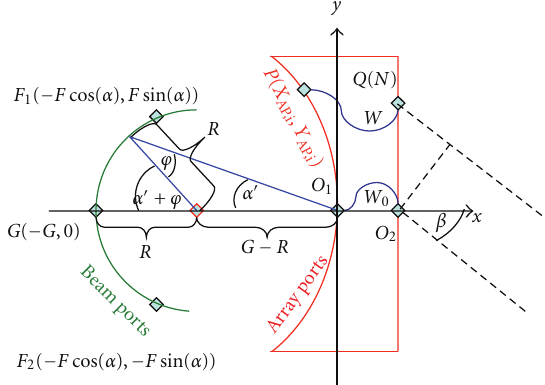
Figure 1: Geometrical parameters of Rotman